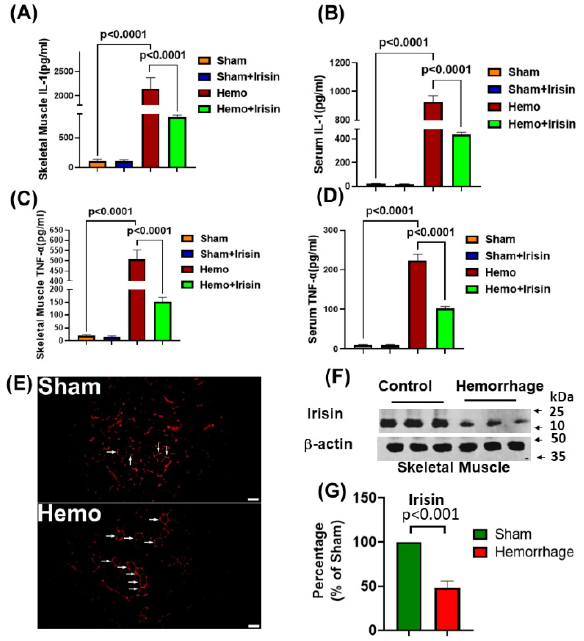
Figure 4. ELISA analysis of IL-1 and TNF- α in serum and skeletal muscle. Bar graphs for ( A ) Levels of IL-1 in skeletal muscle; ( B ) Serum levels of IL-1; ( C ) Levels of TNF- α in skeletal muscle; ( D ) Serum levels of TNF- α . (data are shown as Mean ± SEM, n = 4/each group); ( E ) Immunostaining showing that irisin signals were attenuated by hemorrhage, (Hemo: hemorrhage, Scale bar: 50 µ m); ( F ) Im- munoblot of irisin and β actin in skeletal muscle of mice exposed to hemorrhage; ( G ) Densitometric analysis of irisin in hemorrhage and sham groups. Results were expressed as the percentage of sham group (Data are shown as Mean ± SEM, n = 5/each